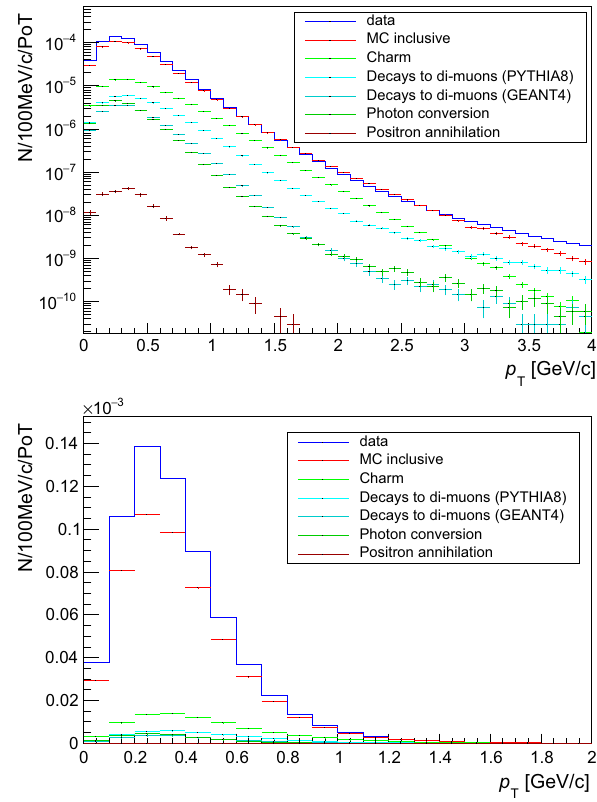
Fig. 6 Transverse momentum distributions from data and simulation, top full range in log scale, bottom detail of lower transverse momen- tum with a linear scale. The distributions are normalized to the number of POT. For the simulation, some individual sources are highlighted, muons from charm (green), from dimuon decays of low-mass reso- nances in Pythia8 (cyan), in Geant4 (turquoise), photon conversion (dark green) and positron annihilation (brown) field turned off. We then take the difference between the tracking efficiency in the simulation with magnetic field off (96.9%) and the measured efficiency (93.6%) as the system- atic error: 3.3%. For more details on the analysis and